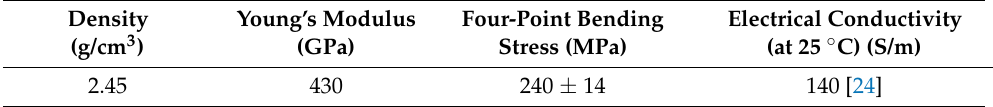
Table 1. Basic parameters of B 4 C tested.